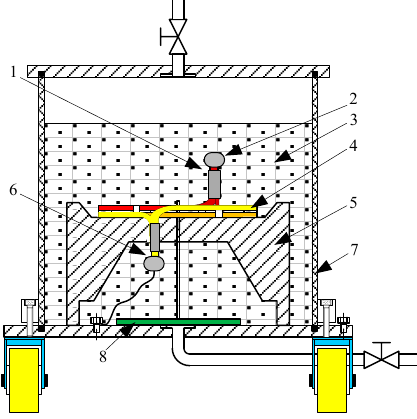
Figure 5. The electrical aging test tank.